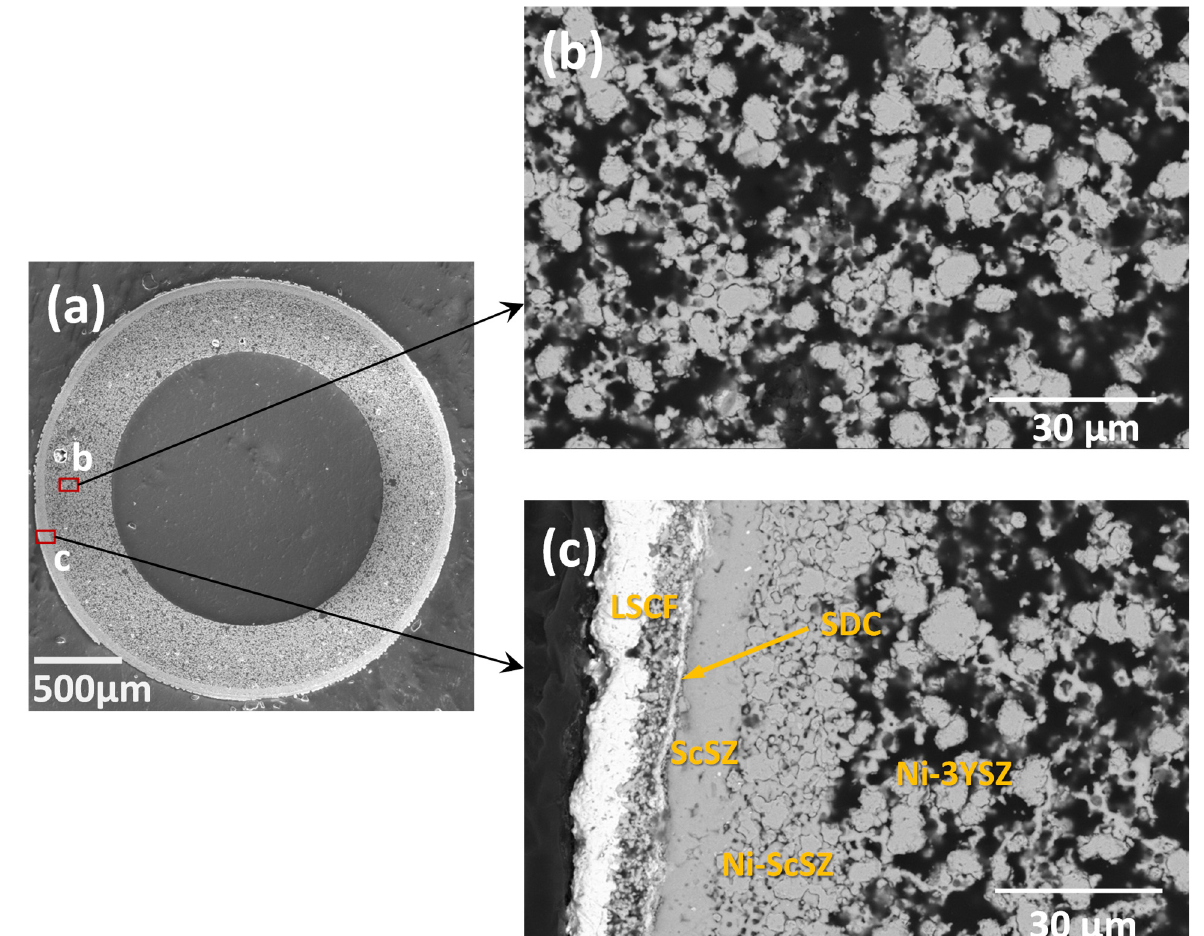
Figure 3. ( a ) A cross-sectional image of the micro-tubular cell after reduction, ( b ) the fuel electrode support layer, ( c ) a close-up view of various layers of the micro-tubular cell.